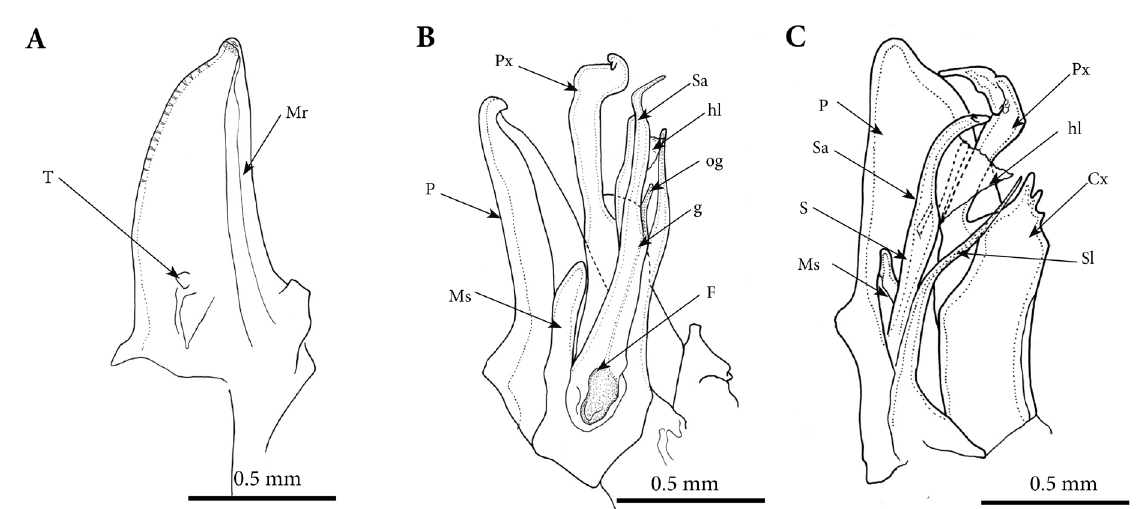
Fig. 3. Ommatoiulus alacygni sp. nov. Holotype ♂, gonopods. A . Right promerite, posterior view. B . Left gonopod, mesal view. C . Left gonopod, posterior